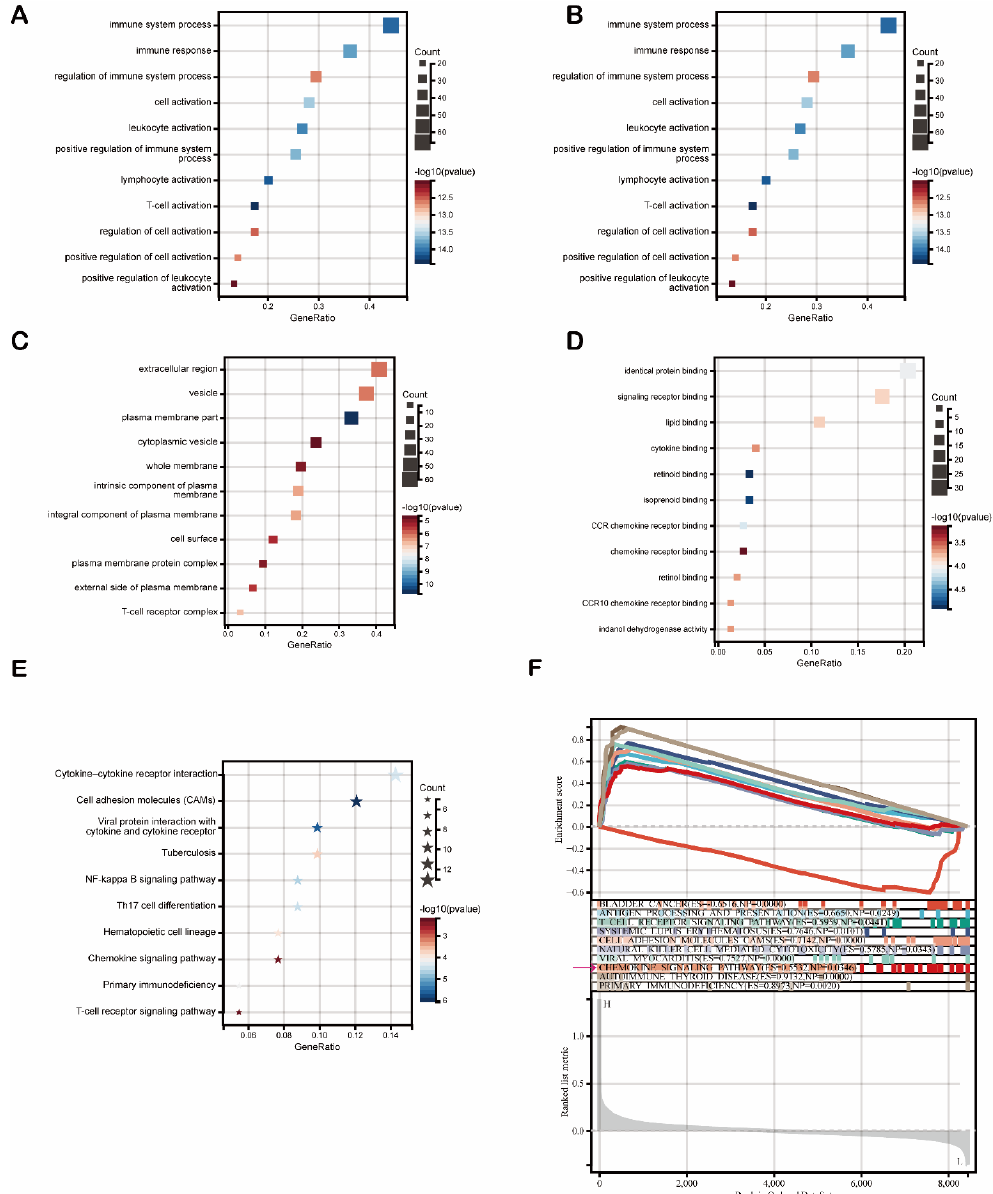
Figure 7. Enrichment analysis of FDCSP. ( A ) GO enrichment. ( B ) GO biological processes. ( C ) GO cellular components. ( D ) GO molecular functions. ( E ) KEGG. ( F ) GSEA of KEGG .